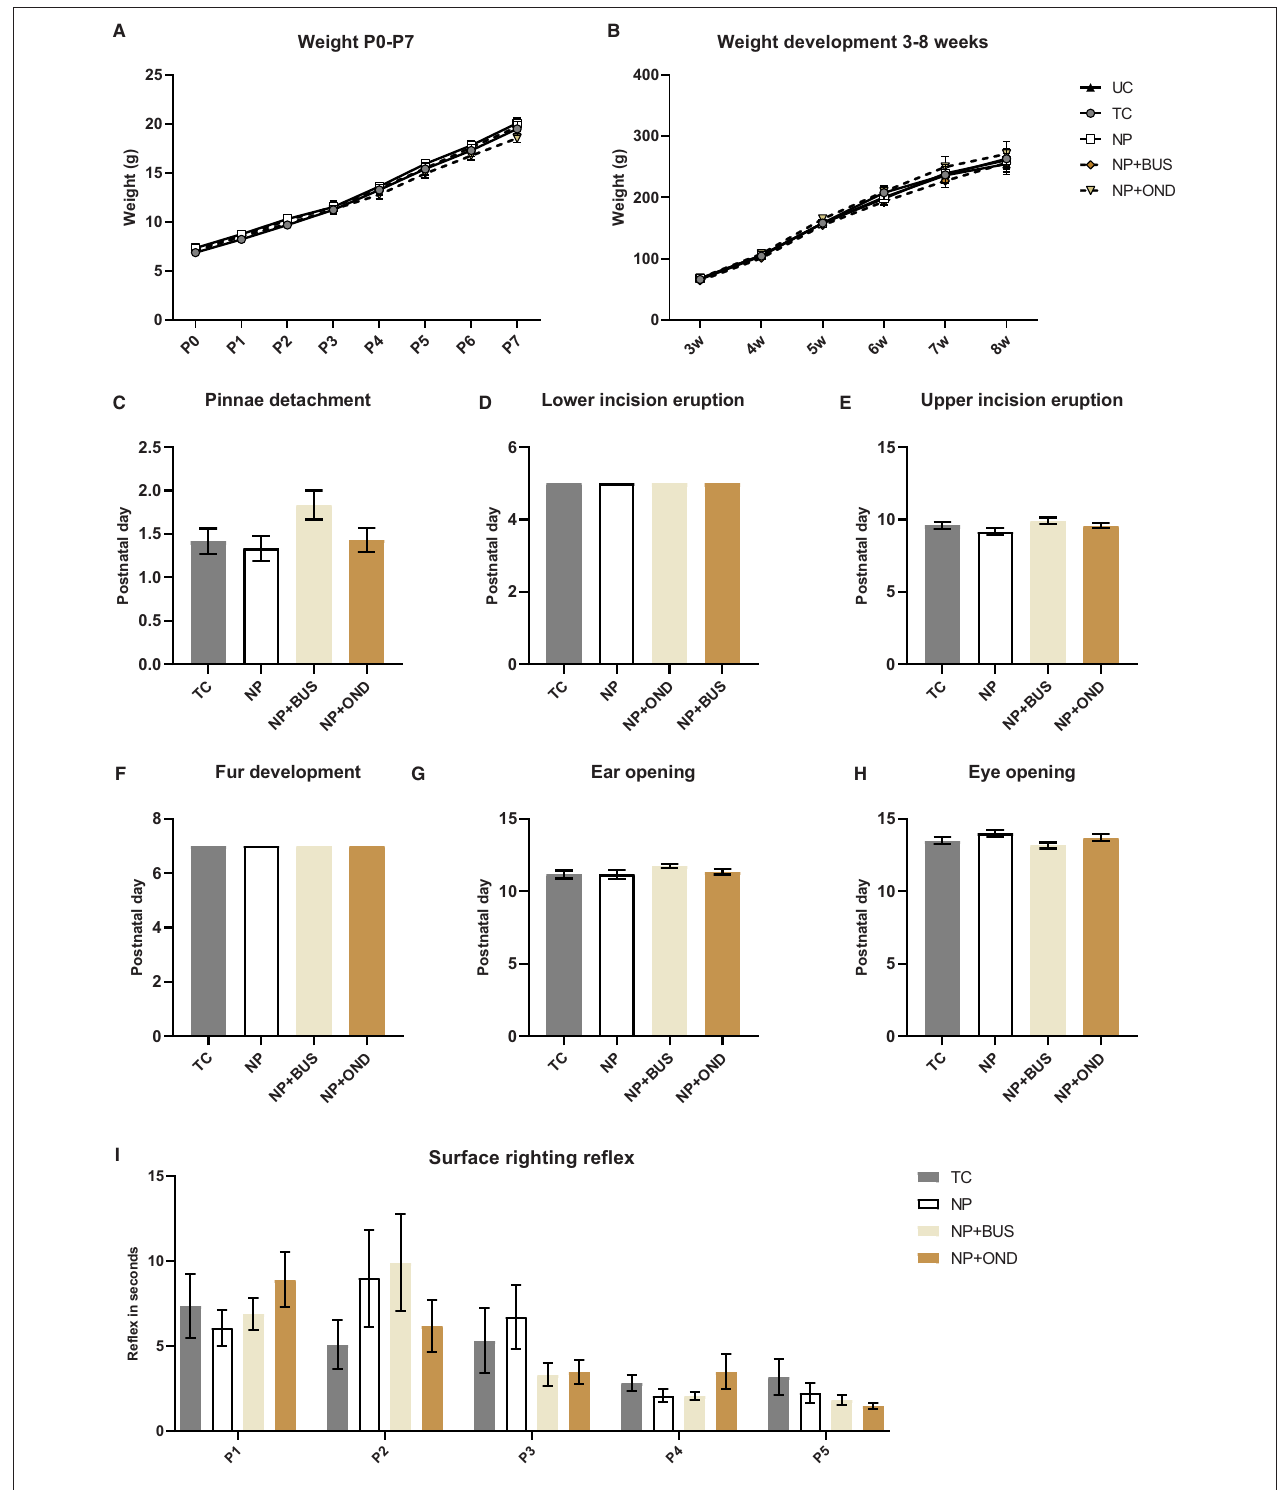
FIGURE 2 | Developmental milestones and weightduring the first postnatal week and during development from 3–8 week of age. (A) Weight during the first postnatal week significantly increases over time [F (2.541, 116.9) = 2628.0; p < 0.01], but is not significantly different between conditions [F (3, 46) = 0.6406; p =